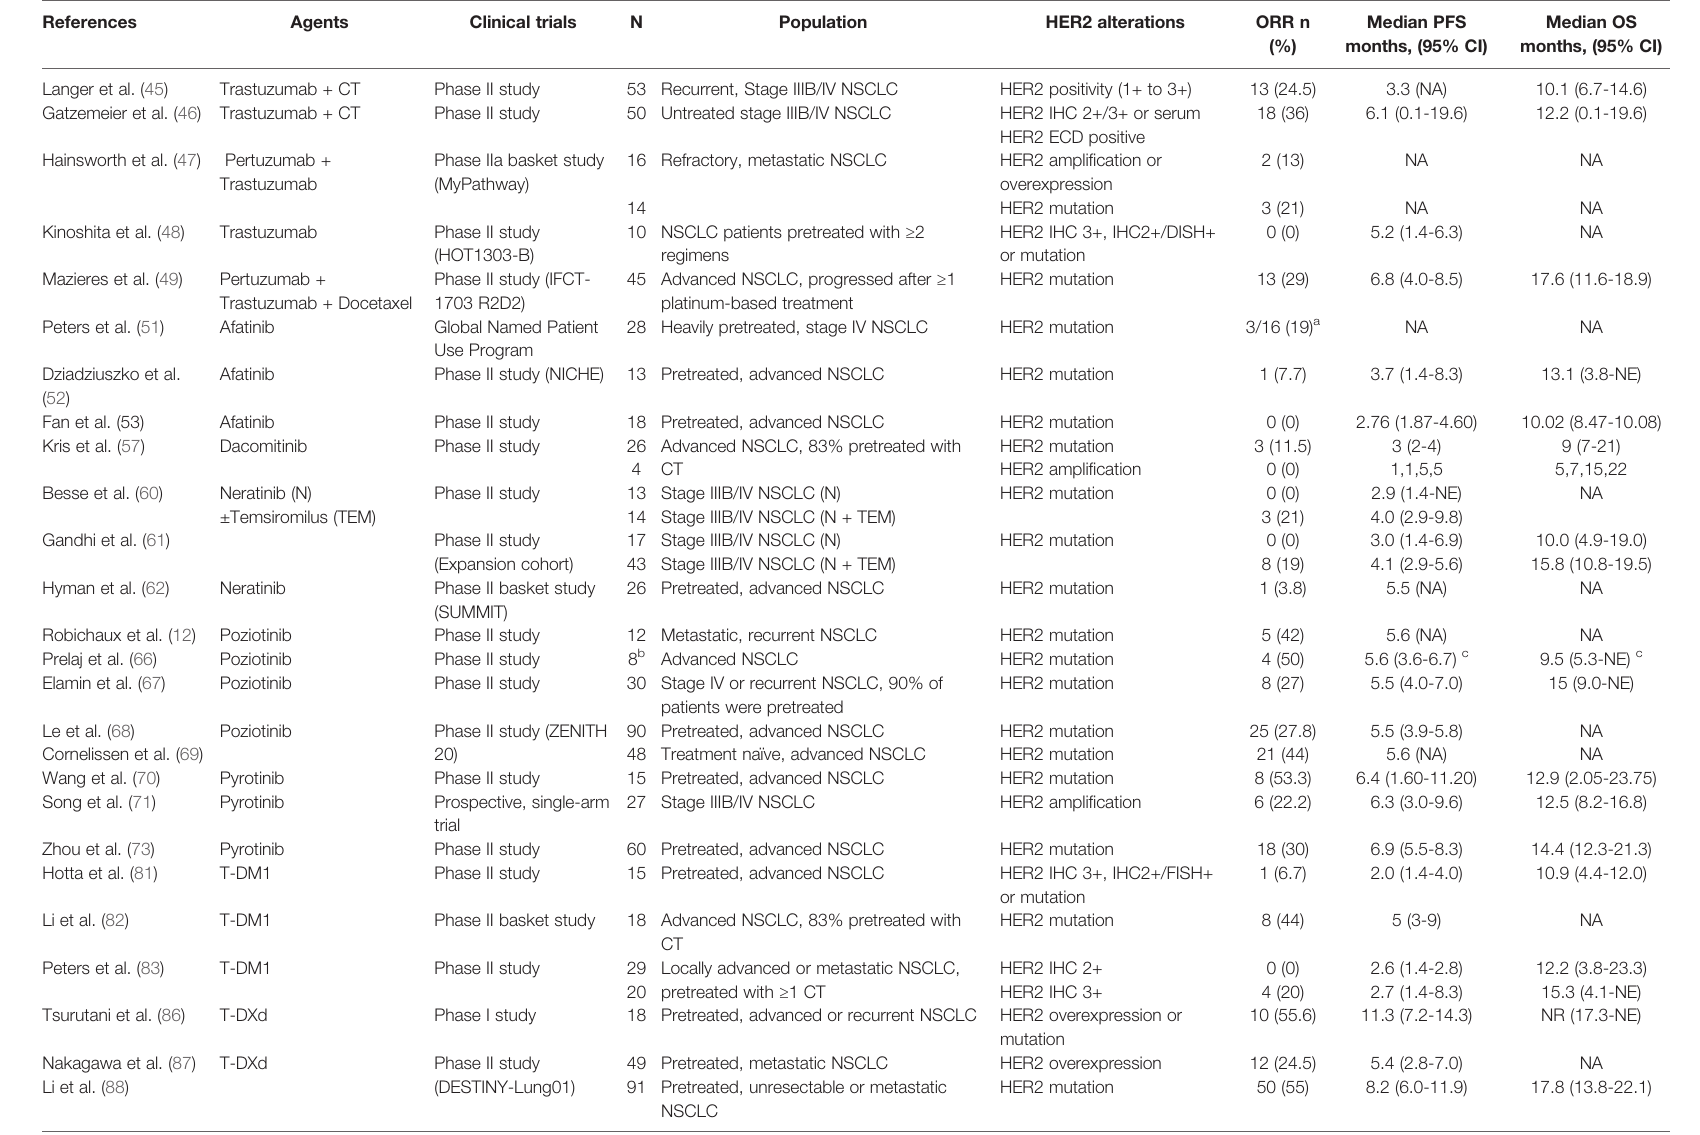
TABLE 1 | Clinical trials of anti-HER2 agents in NSCLC